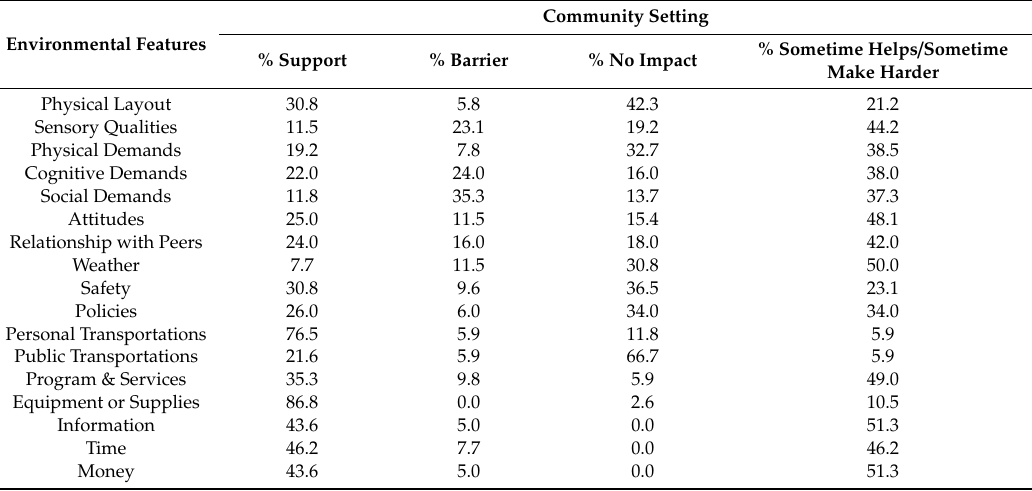
Table 4. Environmental features as perceived by parents in the